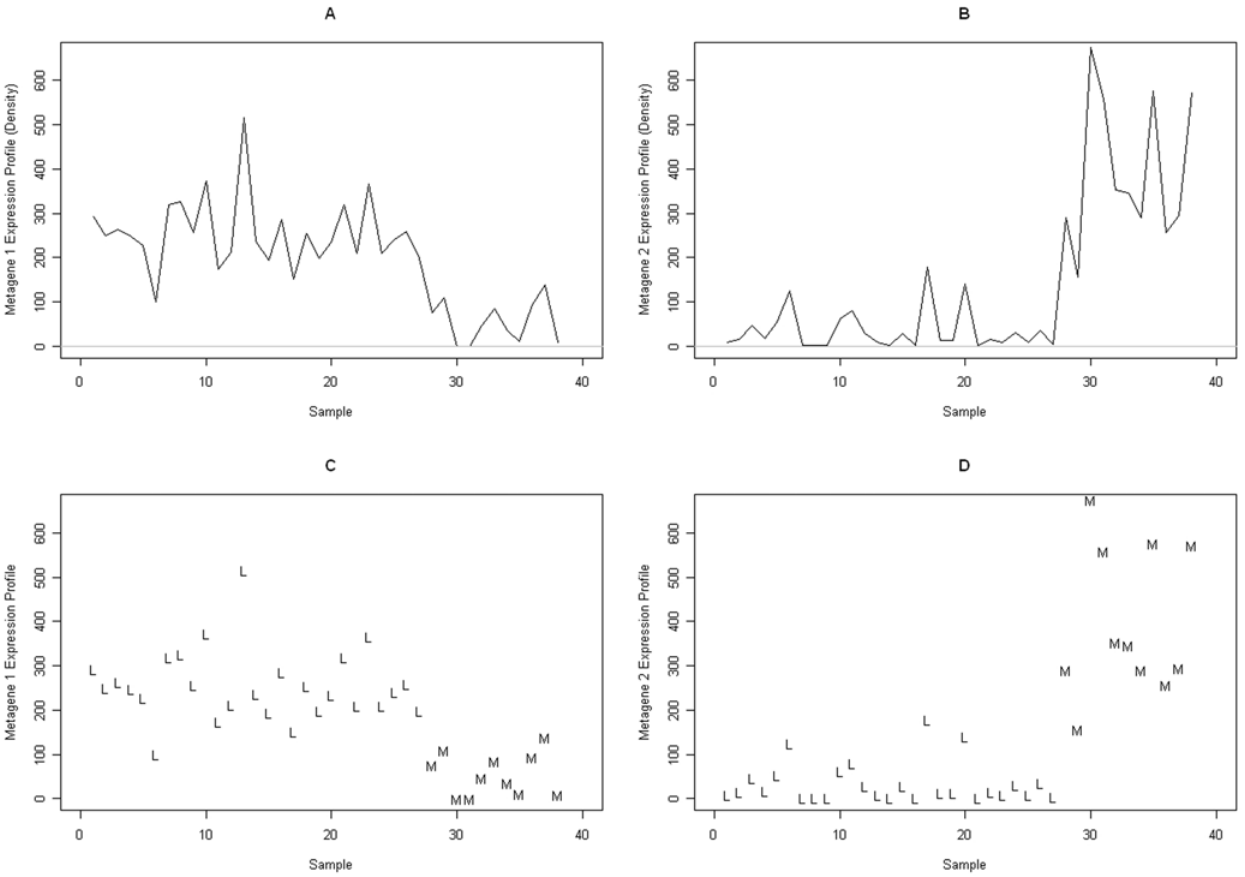
Figure 2. Expression profile. (A) Density of expression profile, metagene 1. (B) Density of expression profile, metagene 2. (C) Expression profile across samples, metagene 1. (D) Expression profile across samples, metagene 2.